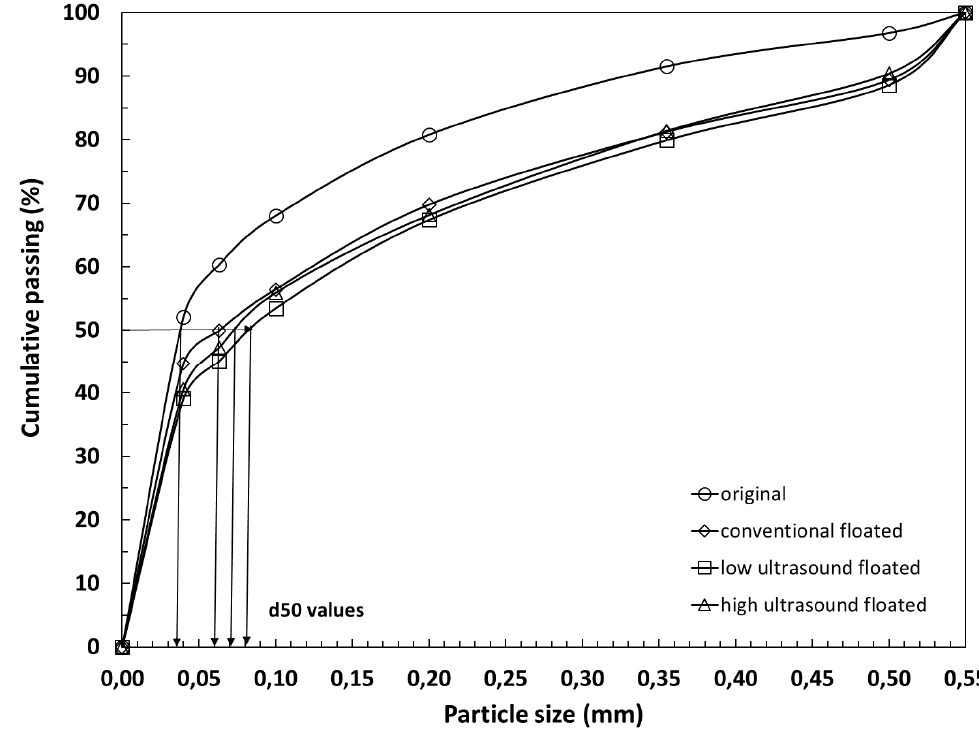
Figure 4. Particle size distributions of the original feed and the froth products due to ultrasonic power levels.